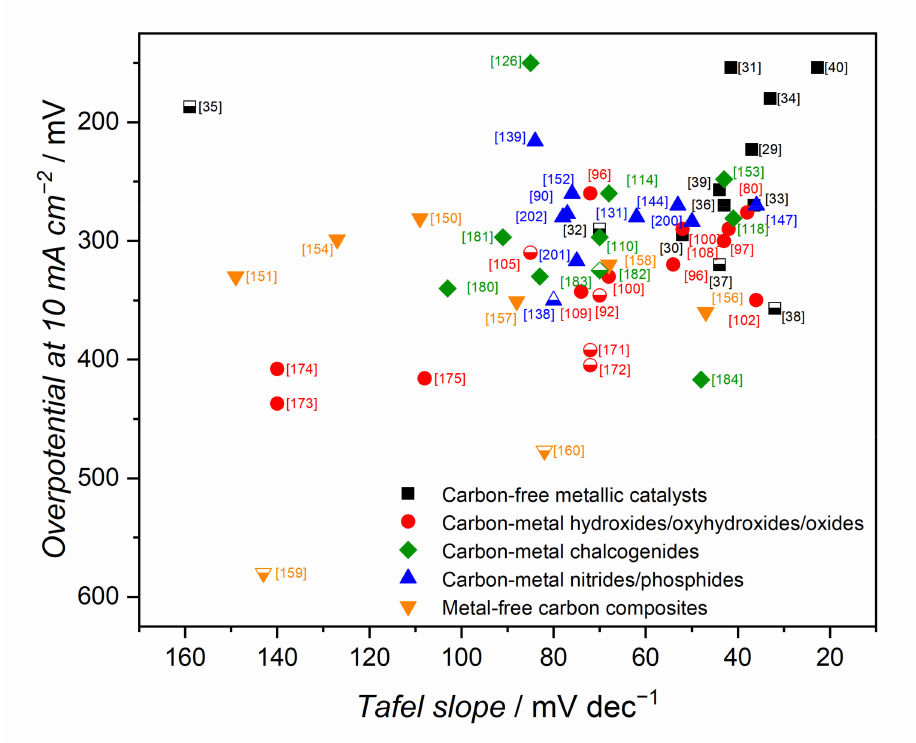
Figure 13. Graphical summary of the best reported electrocatalysts for oxygen evolution reaction divided into different classes of carbon-based composite materials; presented data are for OER process in 1 M (full symbol) and 0.1 M (half-empty symbol) alkaline